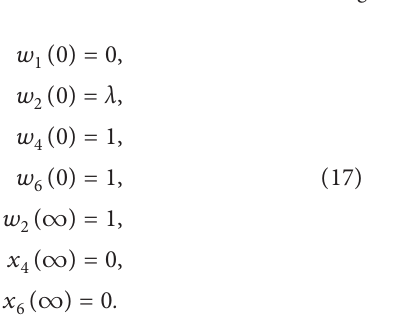
Figure 2: BVPh2 routine algorithm in Mathematica software.